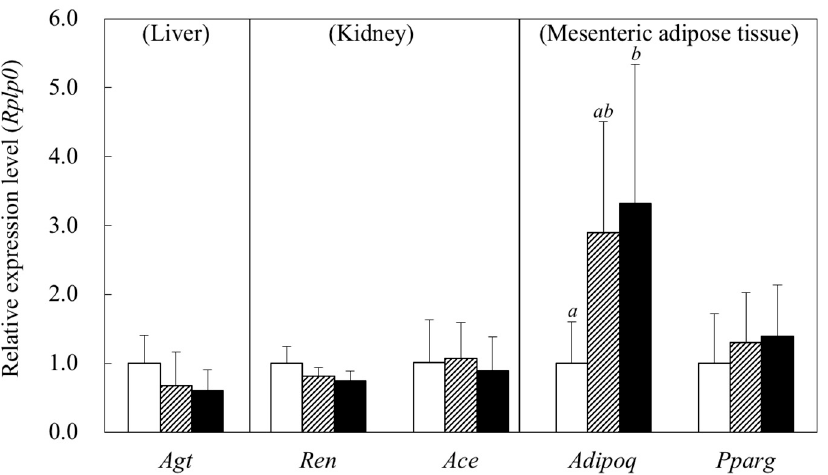
Figure 2. Effect of dietary β -conglycinin on gene expressions in liver, kidney, and mesenteric adipose tissue in SHR. Agt , angiotensinogen; Ren , renin; Ace , angiotensin converting enzyme; Adipoq , adiponectin; Pparg , peroxisome proliferator-activated receptor ganma; Rplp0 , acidic ribosomal phosphoprotein. The mRNA levels were normalized by Rplp0 expression and expressed as the fold induction relative to the Control. The gene expressions were calculated using the 2 − ∆∆ C T method. Open bar, Control (20% casein diet); hatched bar, SOY (the diet containing 10% soy protein isolate with 10% casein); solid bar, β -CON (the diet containing 10% β -conglycinin with 10% casein). Rats were given free access to the diets for 48 days. Values are expressed as mean ± SD of six rats. a , b Values without sharing a common letter are significantly different at p < 0.05.